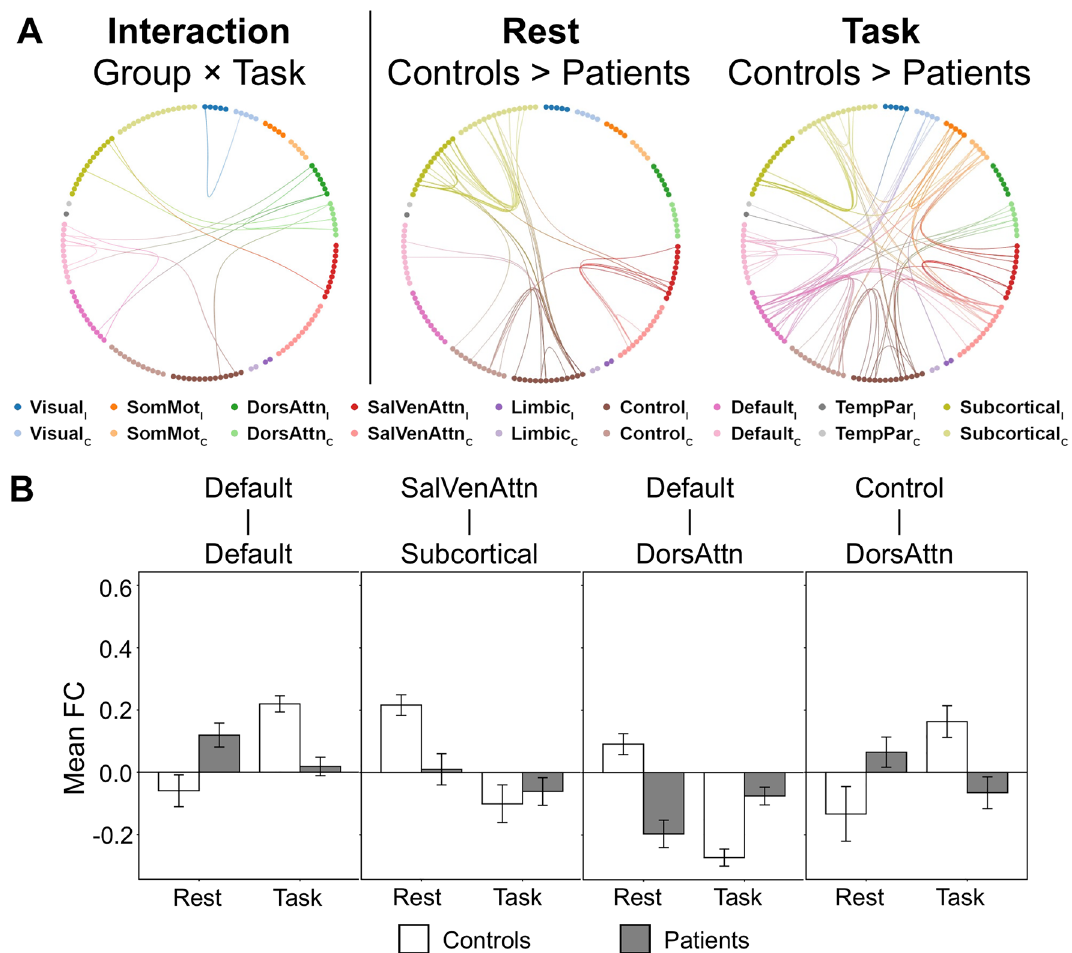
Figure 1. More widespread network disruptions in task-based condition than task-free condition in stroke patients. ( A ) (Left panel) Significant interaction effects of group (patients vs controls) and task (rest vs task) were found in intra-network FC within default and DorsAttn networks and in inter-network FC between default and DorsAttn, control and DorsAttn, SalVenAttn and subcortical networks. (Right panel) Compared to age-matched healthy controls, stroke patients showed lower intra-network FC in control, SalVenAttn, and subcortical networks as well as lower inter-network FC between ipsilesional control and bilateral subcortical networks during the task-free condition. During the task-general condition, stroke patients had more widespread network disruptions than resting-state, including lower intra-network FC in default, control, SalVenAttn, SomMot, and subcortical networks. Additionally, lower inter-network FC was found between ipsilesional default and other contralesional networks (except limbic and subcortical), ipsilesional control and other contralesional networks (except limbic, visual, and TempPar), as well as contralesional SalVenAttn and bilateral SomMot and subcortical networks. ( B ) The average FC of edges showing significant interaction effect for four representative networks impaired based on NBS statistics in panel ( A ) were shown. Data are presented as mean ± standard error. C contralesional, DorsAttn dorsal attention, FC functional connectivity, I ipsilesional, NBS network-based statistics, SalVenAttn salience/ventral attention, SomMot somatomotor, TempPar